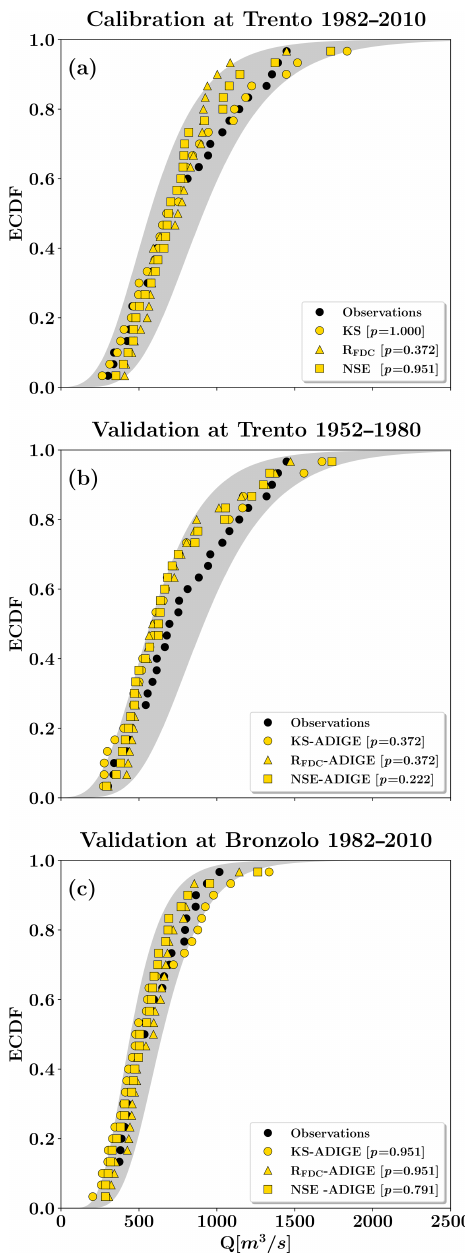
Figure 3. ECDFs of the daily annual streamflow maximum obtained using the observational dataset ADIGE and the NSE-ADIGE, KS- ADIGE and R FDC -ADIGE parametrizations at (a) the Trento gaug- ing station during the 1982–2010 period, (b) the Trento gauging station during the 1952–1980 period and (c) the Bronzolo gaug- ing station during the 1982–2010 period as input. The experimen- tal ECDFs obtained from streamflow observations during the same time frames are shown using black bullets, and the gray shaded area indicates the associated 90% confidence interval of the fitted Gum- bel distribution. The p values of the Kolmogorov–Smirnov two- sample test are also reported in brackets for each simulation